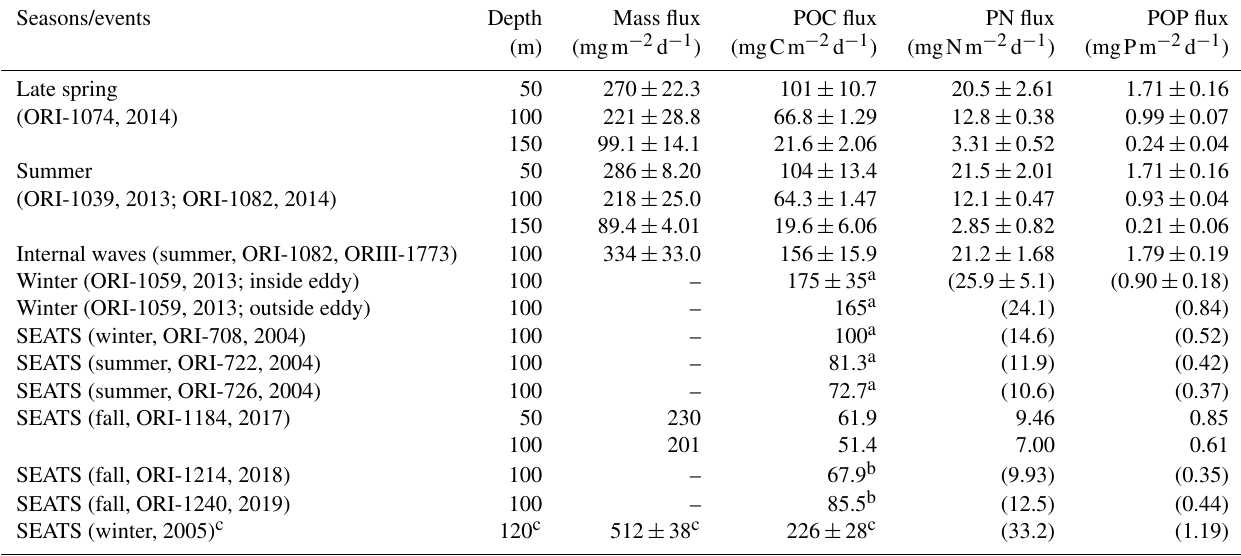
Table 3. A list of measured and estimated fluxes of total mass, POC, PN, and POP in various sampling seasons and oceanic events in NSCS.